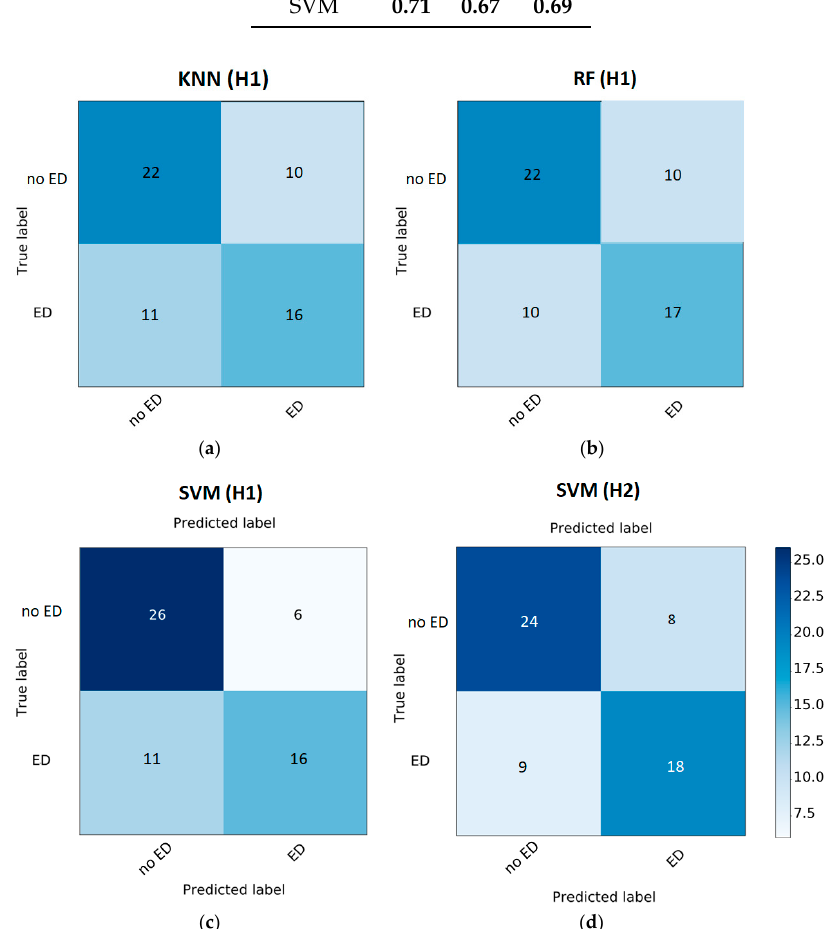
Figure 4. Confusion matrices (CMs) obtained when classifying photoplethysmography features (H1) with: ( a ) K-Nearest Neighbor (KNN); ( b ) Random Forest (RF); and ( c ) Support Vector Machine (SVM) classifier. ( d ) CM for SVM obtained when testing H2 (both photoplethysmography and anthropometric